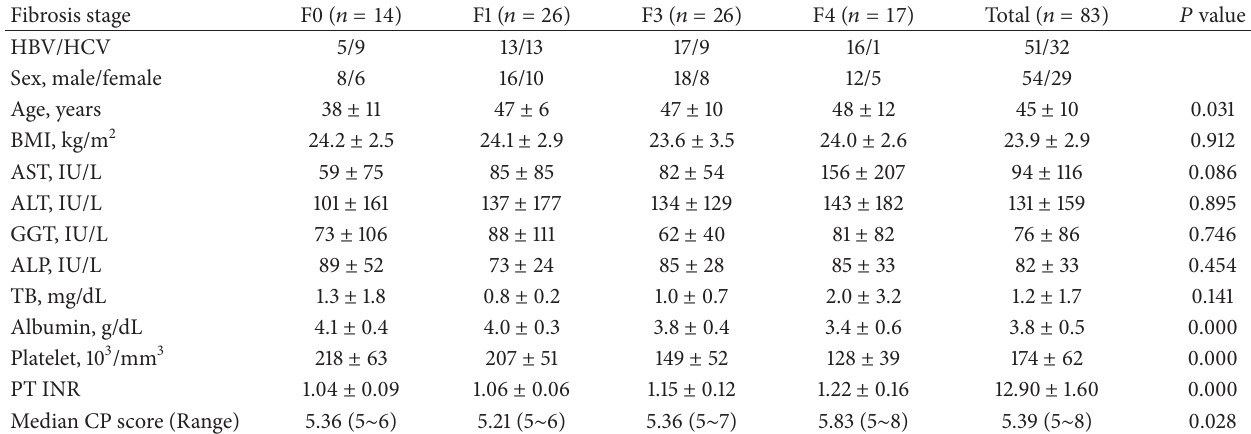
Table 1: Baseline characteristics of patients according to the histologic fibrosis